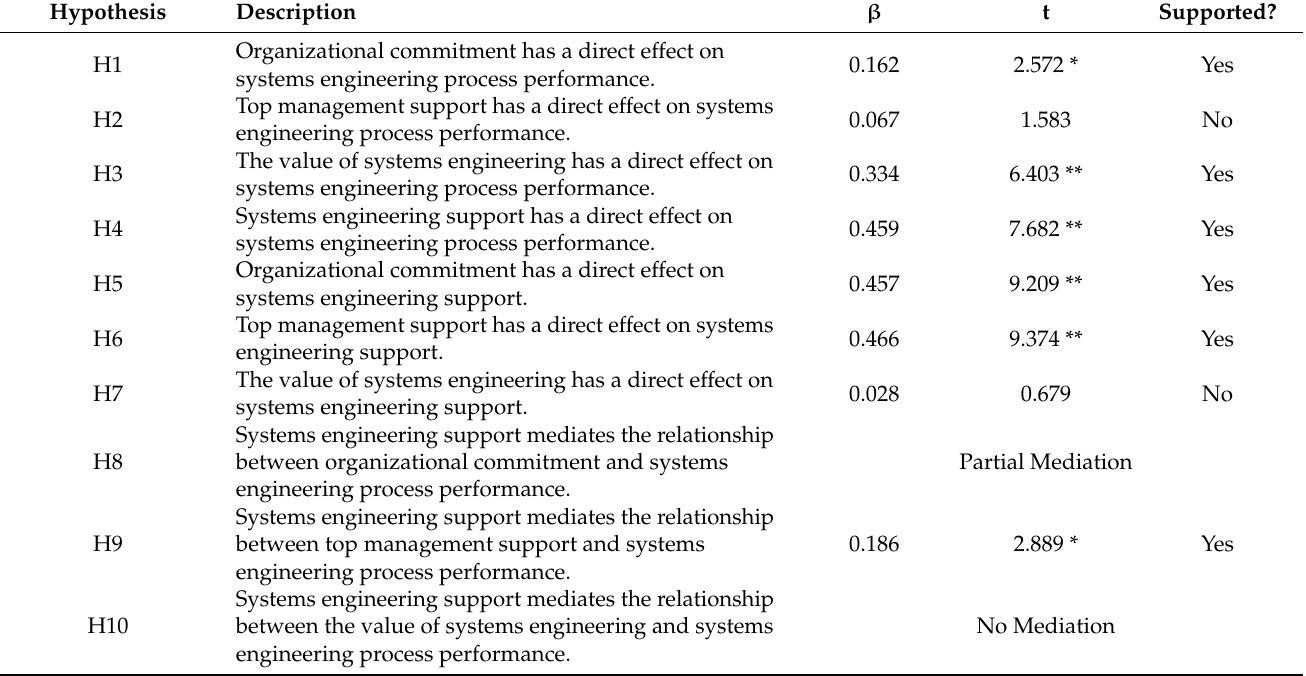
Table 10. Hypothesis Testing